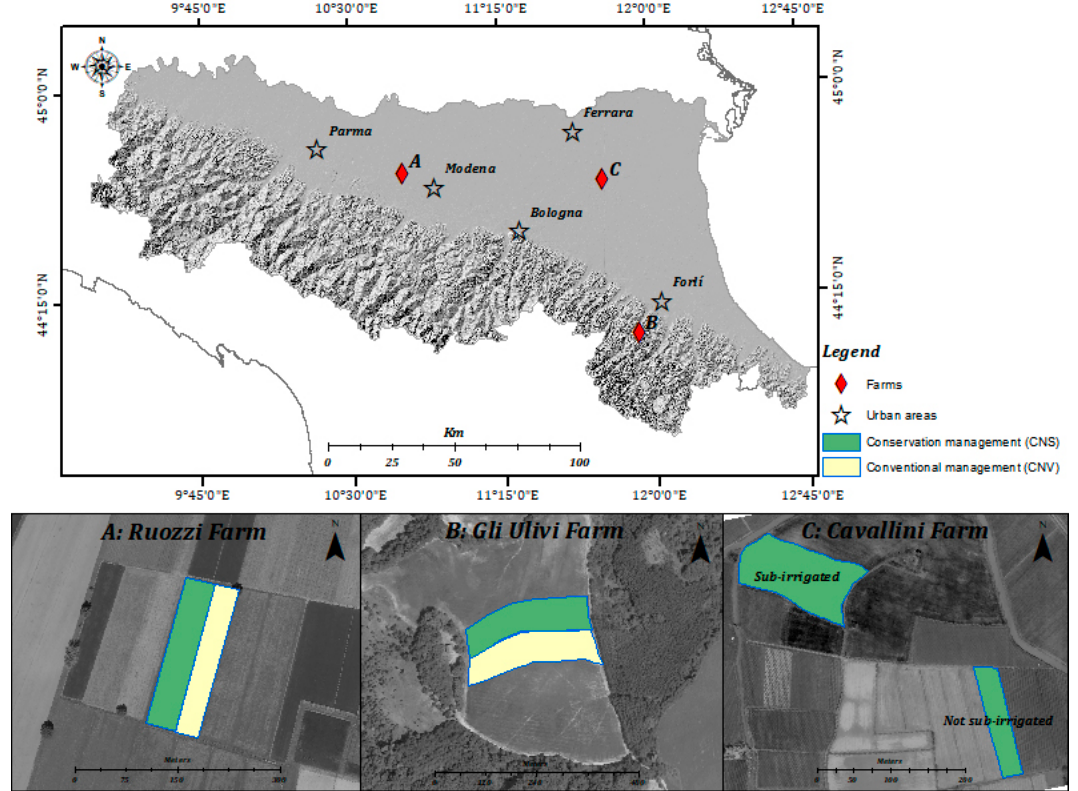
Figure 1. Geographical position of the three farms in the Emilia-Romagna region, using ArcGIS (version 10.4.1) and Google Earth Pro (v. 7.3.2.5776): ( A ): Ruozzi farm; ( B ): Gli Ulivi farm; ( C ): Cavallini farm [40–43].